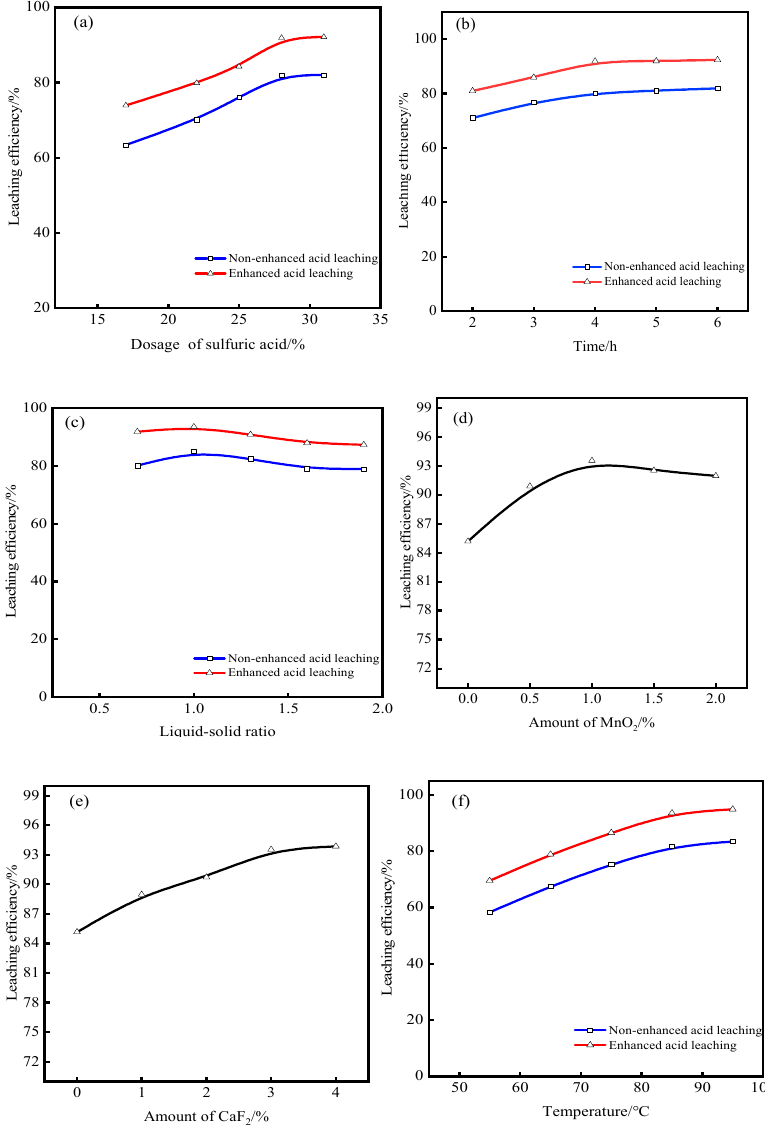
Figure 6. Factors affecting leaching efficiency: ( a ) dosage of sulfuric acid; ( b ) time; ( c ) liquid–solid ratio; ( d ) dosage of MnO 2 ; ( e ) dosage of CaF 2 ; and ( f ) temperature.